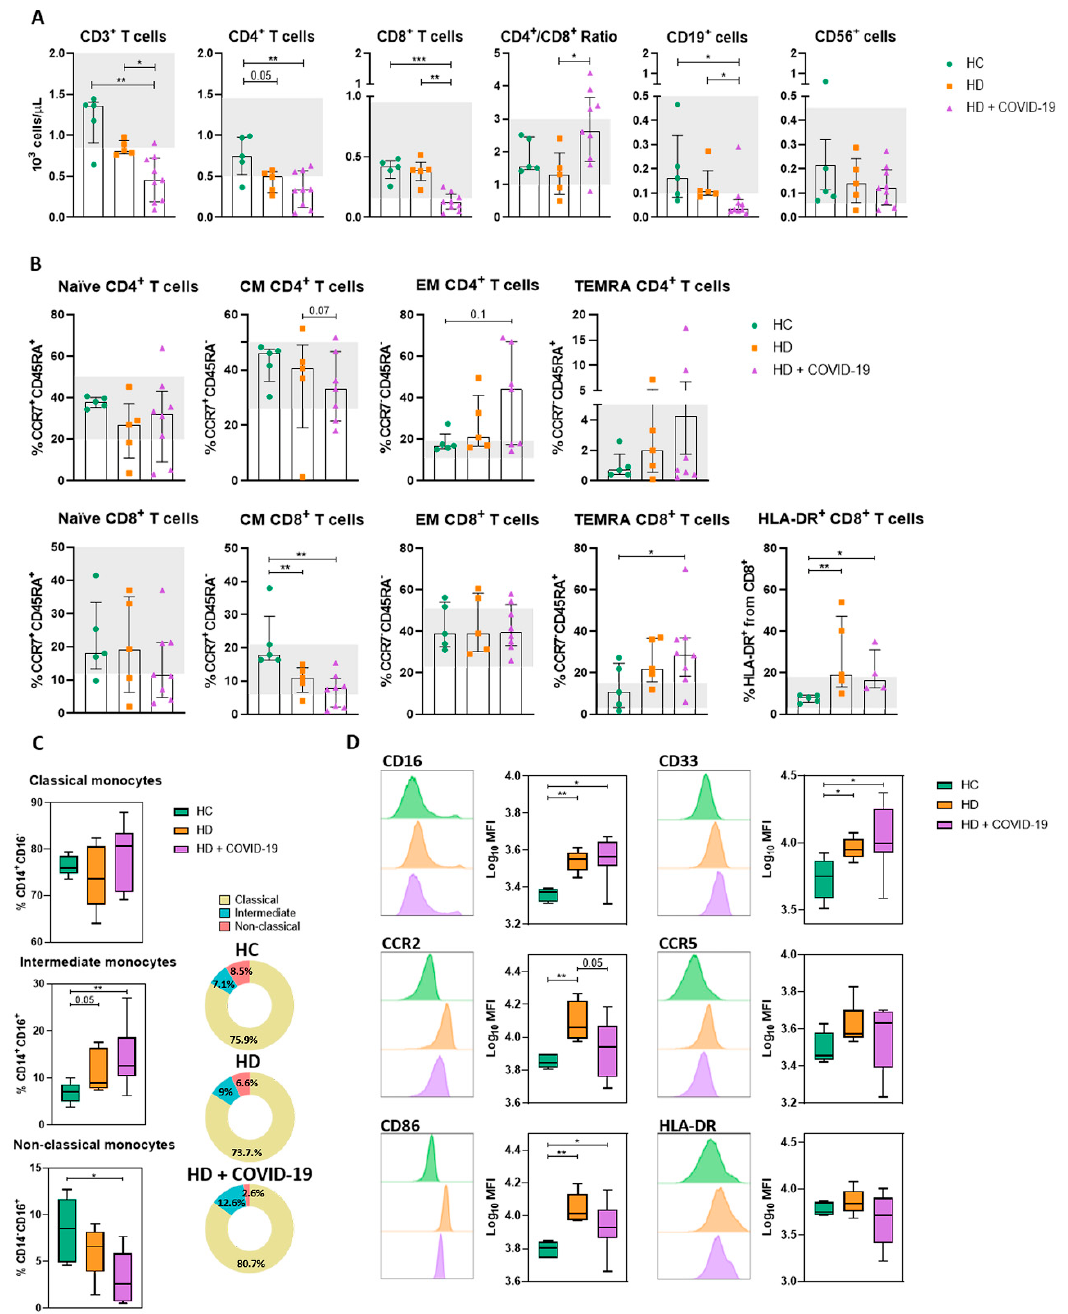
Figure 2. Flow cytometry analysis of adaptive and innate cell subpopulations of HC, HD and HD + COVID-19 patients. ( A ) T, B and NK cell phenotype. ( B ) Percentage of CD4+ and CD8+ T cell subsets (naïve, central memory [CM], effector memory [EM] and terminally differentiated effector memory [TEMRA]) according to the expression of CD45RA and CCR7. Grey regions depict reference frequency ranges obtained from representative healthy donors in our clinical immunology